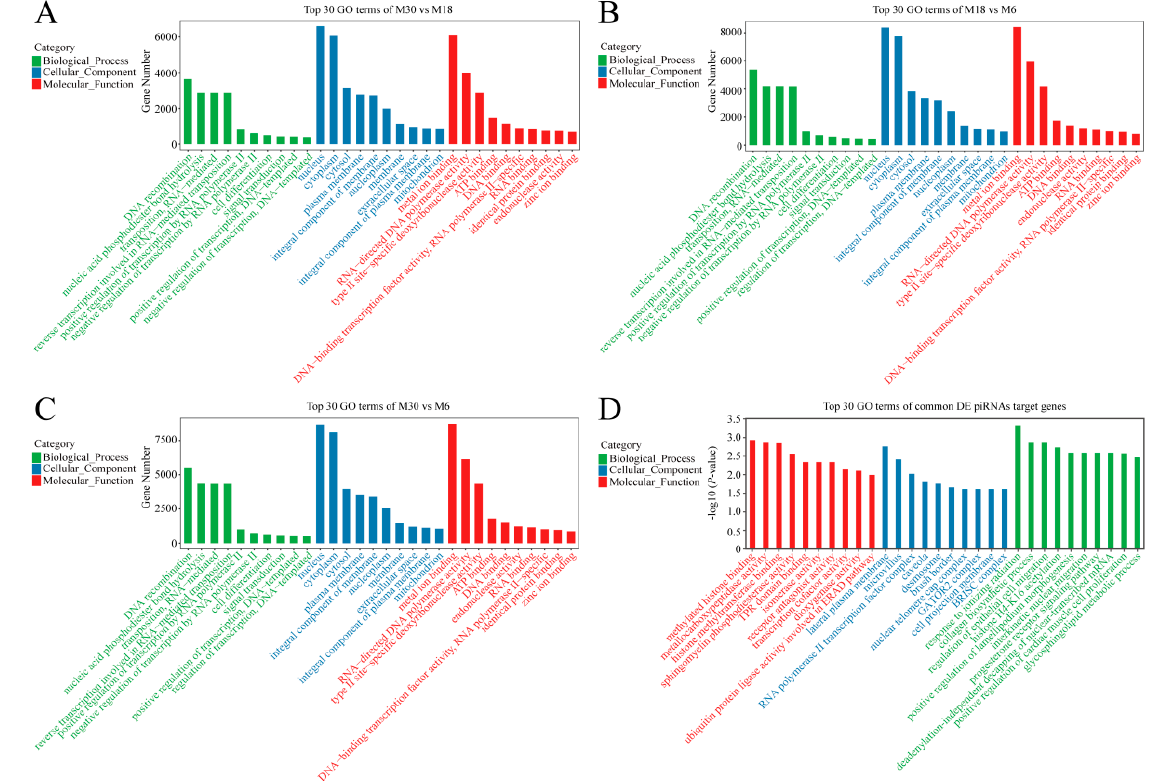
Figure 3. GO analysis of differentially expressed piRNA’s target genes. ( A ) GO enrichment analysis of differentially expressed piRNA’s target genes between M30 and M18; ( B ) GO enrichment analysis of differentially expressed piRNA’s target genes between M18 and M6; ( C ) GO enrichment analysis of differentially expressed piRNA’s target genes between M30 and M6; ( D ) GO enrichment analysis of common differentially expressed piRNA target genes.